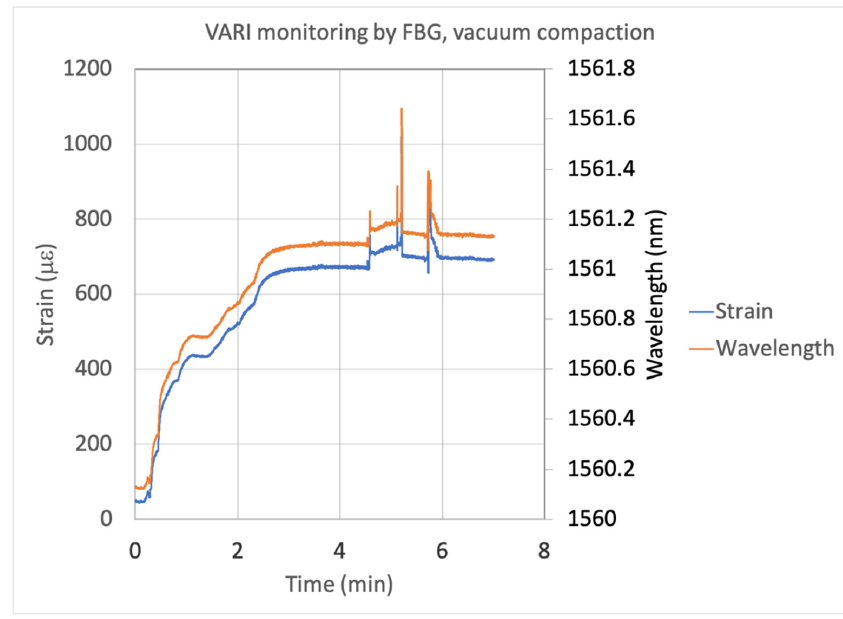
Figure 6. VARI monitoring by FBG, vacuum compaction with point loads at FBG location.